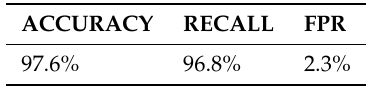
Table 4. Result of